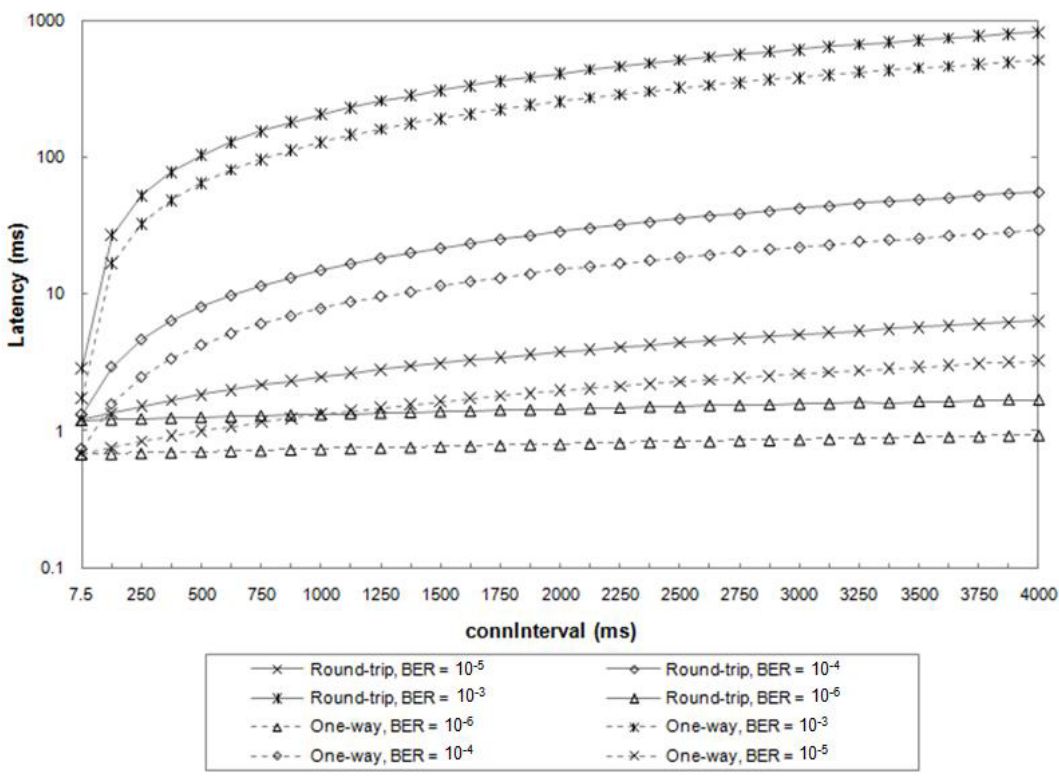
Figure 25. Average latency for one-way and round-trip message exchanges, for various connInterval and BER values. Adapted from